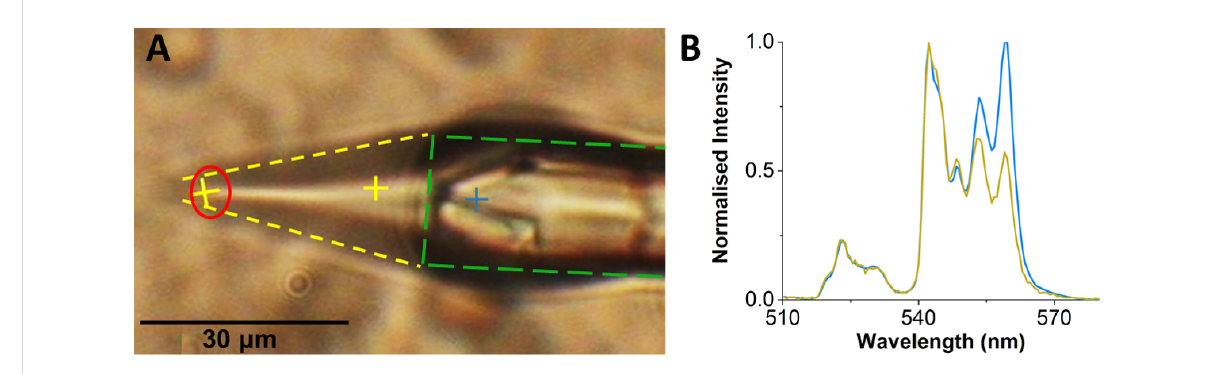
Figure 5: (A) An image showing an electrospray jet of 0.8 pM upconverting solution (yellow lines) from a glass pipette (green lines). The red circle represents the tip of a Taylor cone. (B) Emission spectra of UCNPs at different regions as marked in panel (A) with respective colors. It shows a marked difference in the nature of spectra of UCNPs when they are in a glass pipette or flowing in a Taylor cone.